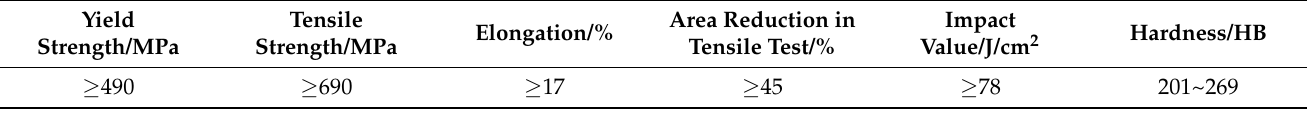
Table 1. Technical requirements for the mechanical properties of the boom.